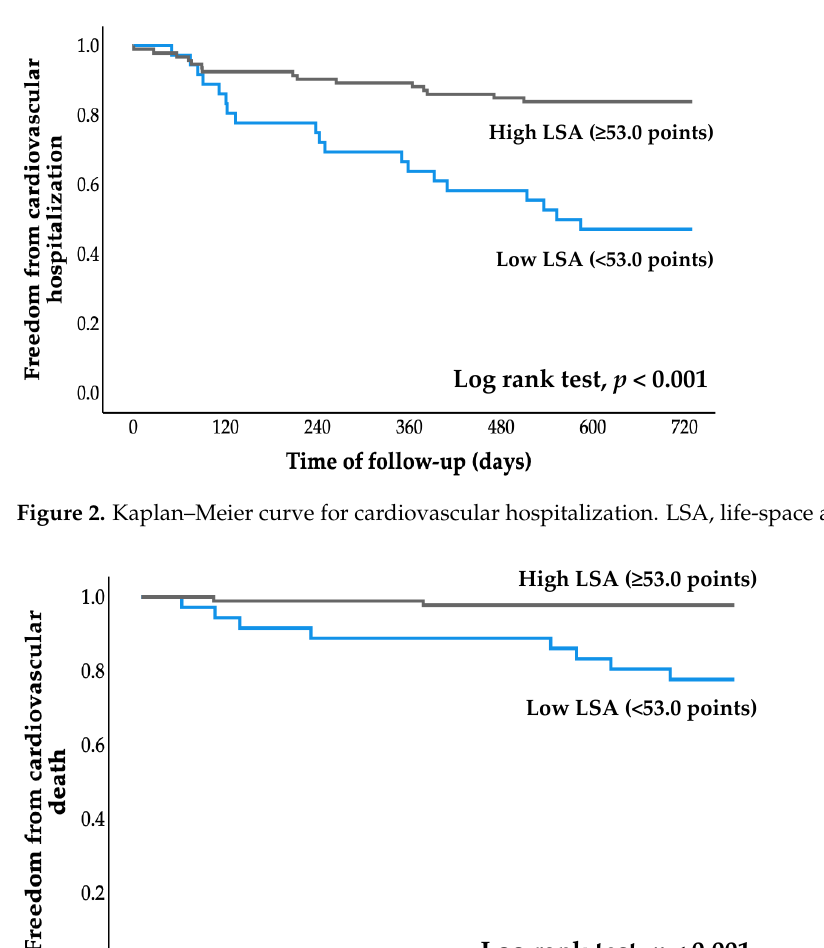
Log rank test, p < 0.001